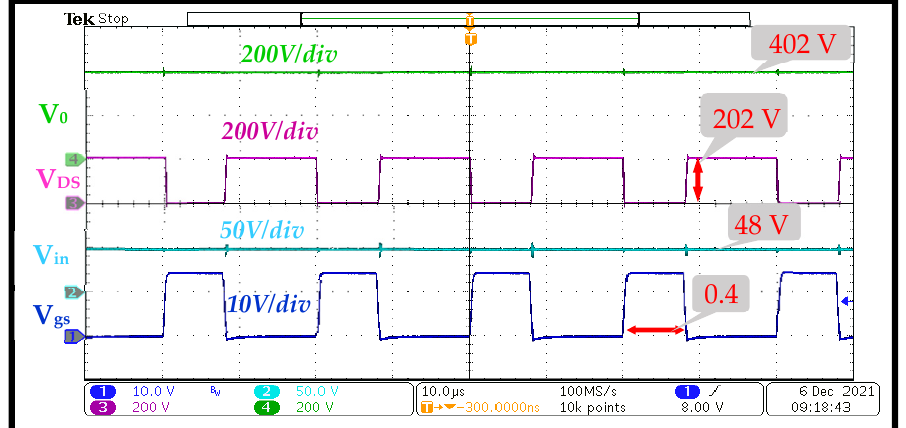
Figure 19. Experimental waveform of input voltage (V in ), ( 1 ) Duty cycle (V gs ) at d = 0.4, ( 2 ) Input Voltage (V in ), ( 3 ) Drain to Source voltage and ( 4 ) output voltage (V 0 ).